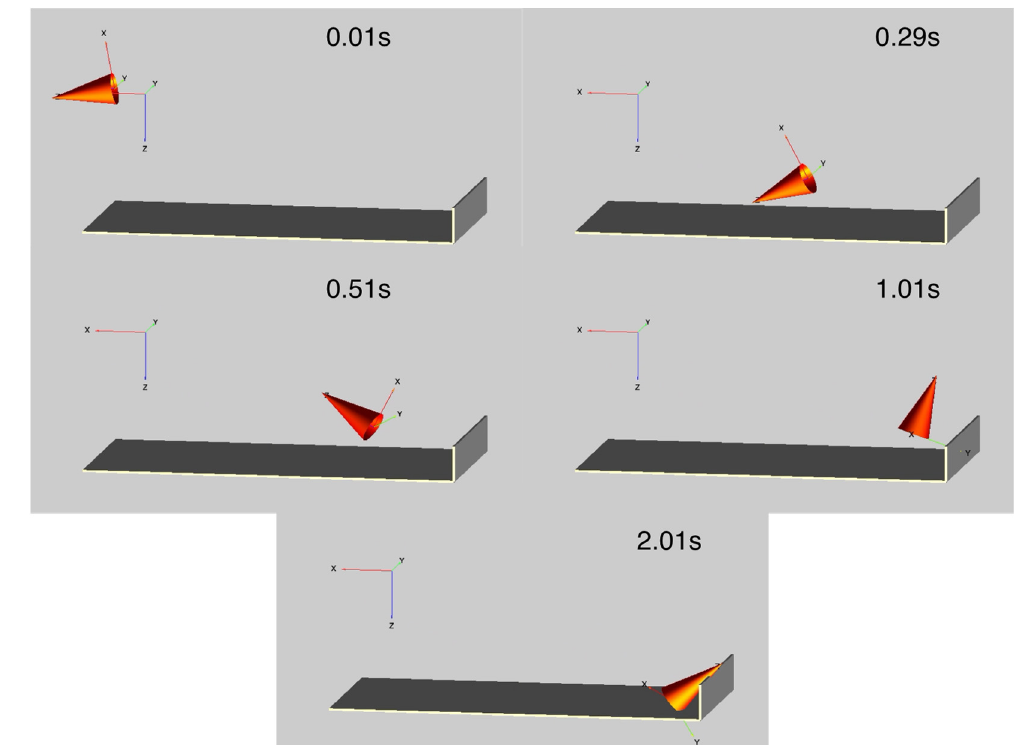
Figure 4. Selected animation frames showing the motion of the test object being thrown into the soft-catch pit. Time of 0.01 s shows the initial location prior to movement and 2.01 s shows the final resting location.